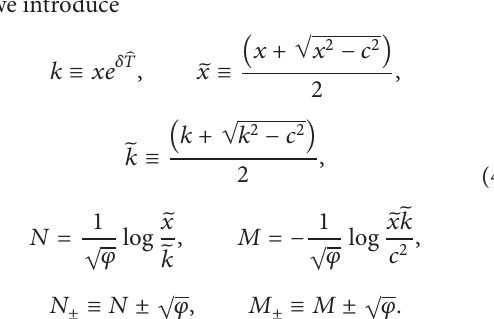
Figure 5 1) = max 𝑋 𝑡 ≤ 𝑠 ≤ 𝑇 𝑠 ). We next 𝑇